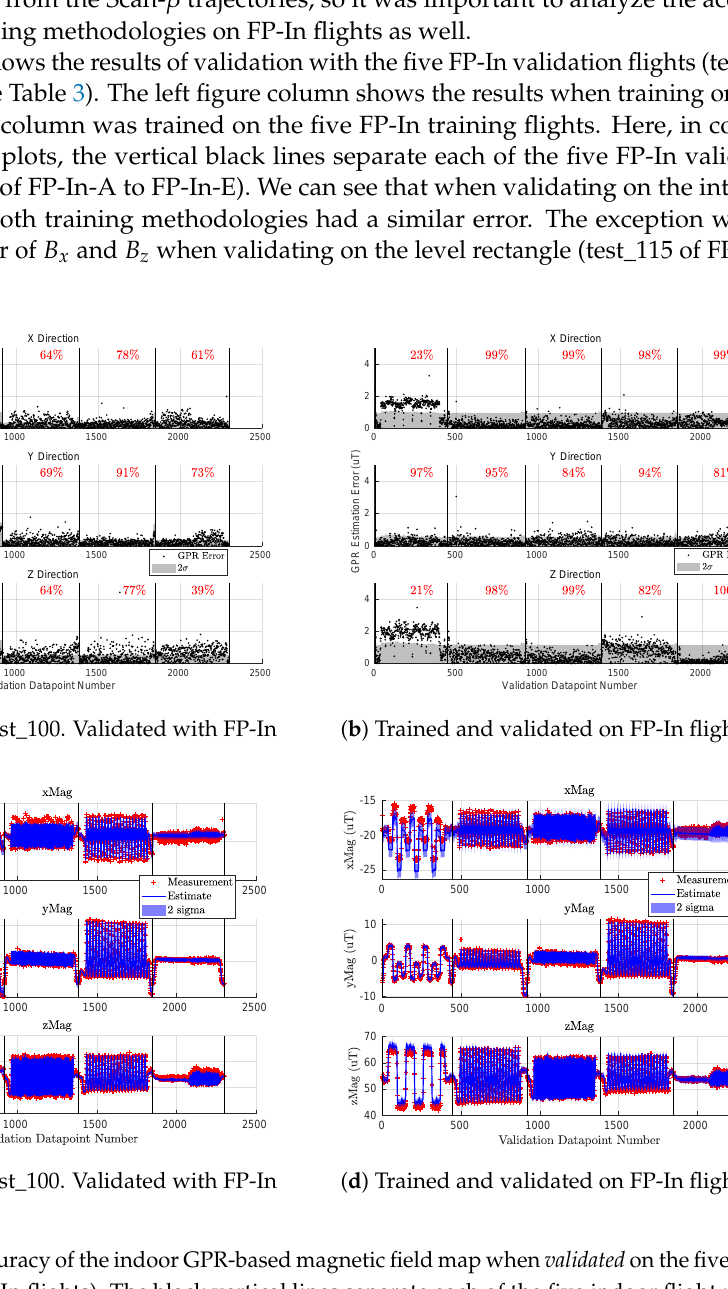
Figure 10. The accuracy of the indoor GPR-based magnetic field map when validated on the five indoor flight profiles (FP-In flights). The black vertical lines separate each of the five indoor flight profiles. The steady-state error in Figure 10b was likely caused by a misalignment with the magnetometer in test_105 (FP-In-A training